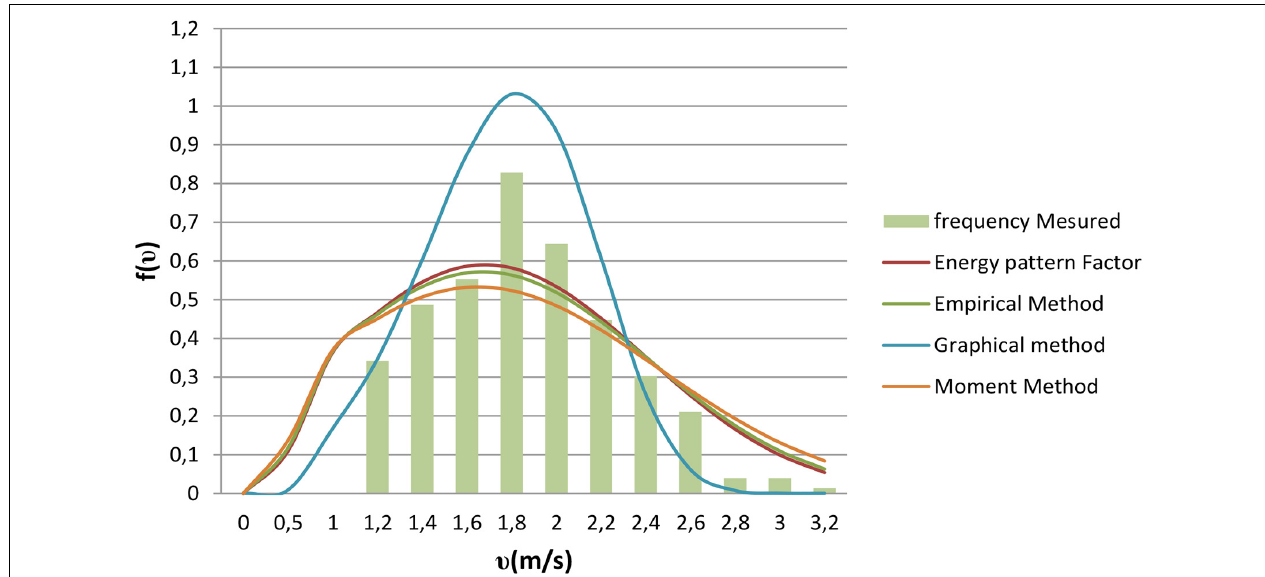
FIGURE 4 | Distribution of Weibull function and frequency measured, year 2014.